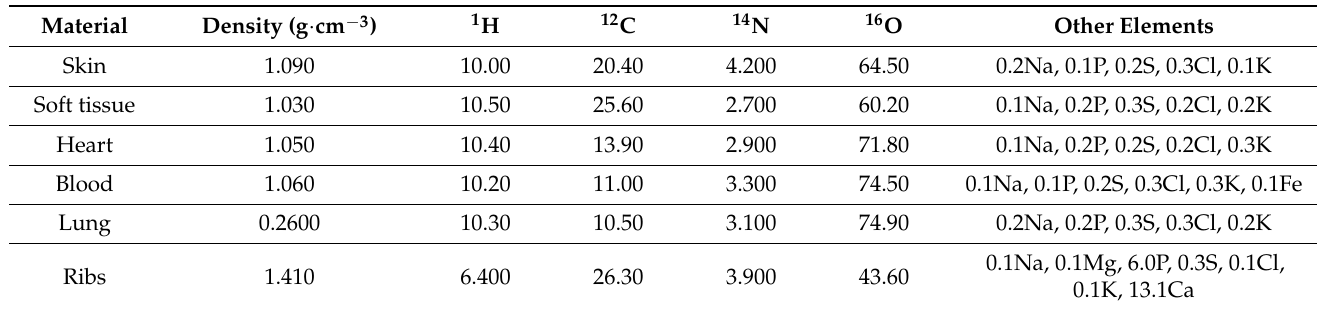
Table 2. Densities and materials composition (shown in weight percent) of the MIRD anthropomorphic